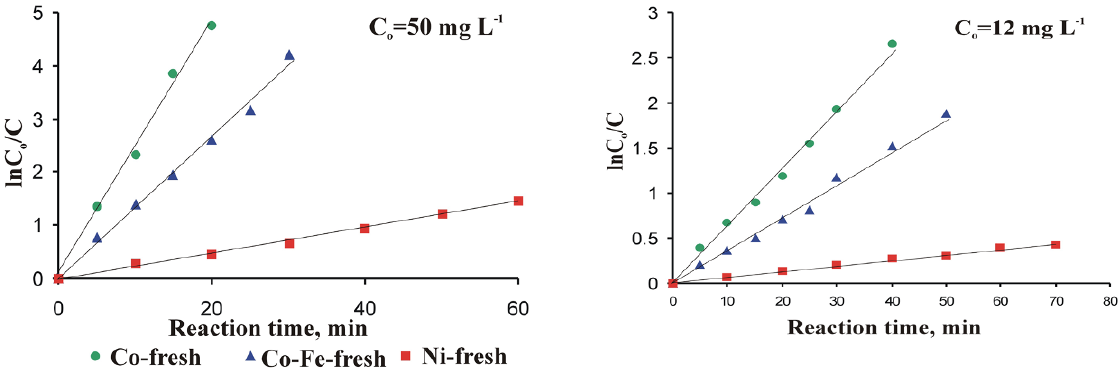
Figure 6. First-order fit of MB liquid-phase oxidation in the presence of Ni-fresh, Co-fresh and Co- Fe-oxide